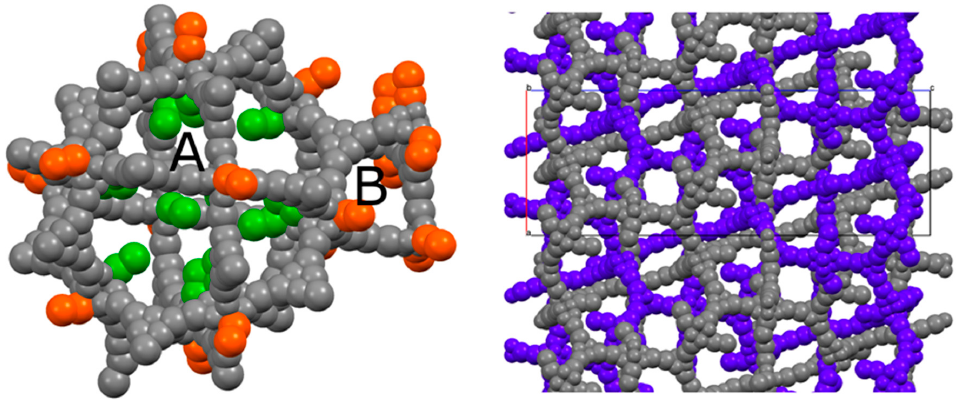
Figure 4. ( Left ) Schematic view of the pores of the simple PCN-6@nicotine net: two cavities, A (large, cubo-octahedral) and B (small, tetrahedral), are evident; the MOF skeleton is schematized in grey with pseudo-atoms, nicotine molecules are represented by the centre of mass of the rings, in green the 12 pointing inside the A cavity, and in orange those belonging to the neighbouring pores. ( Right ) The two interpenetrated nets of PCN-6@nicotine are schematized with the same representation, showing that pores are partitioned, but not completely filled.